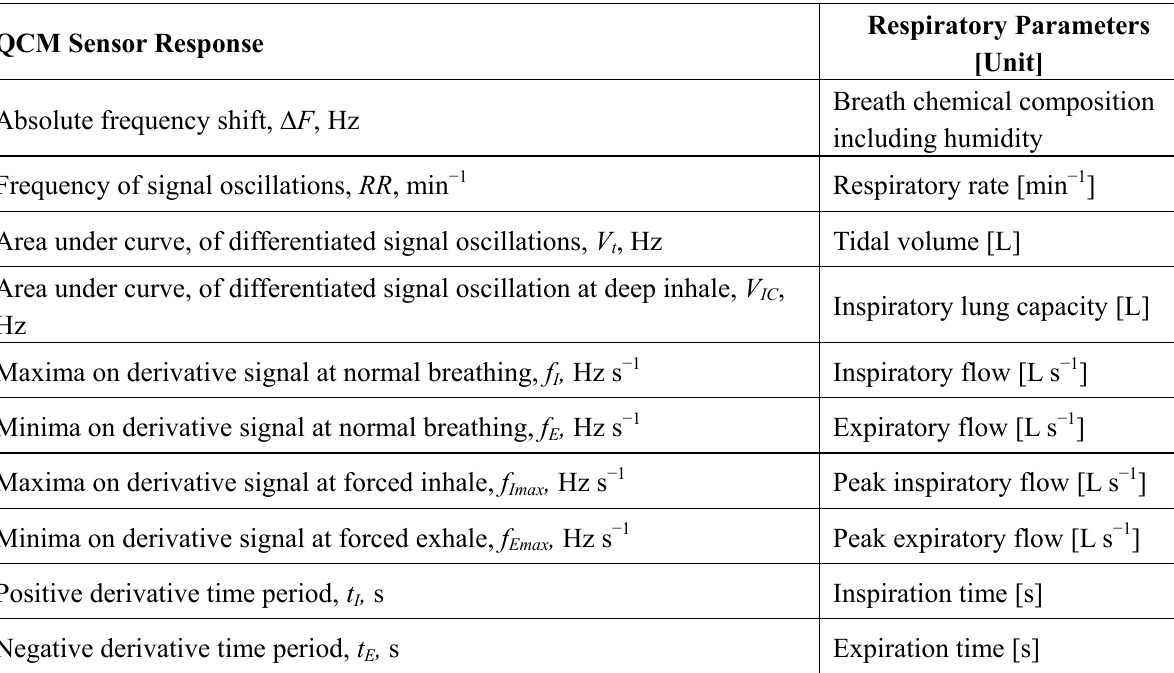
Table 1. Assumed relationship between QCM sensor responses and respiratory